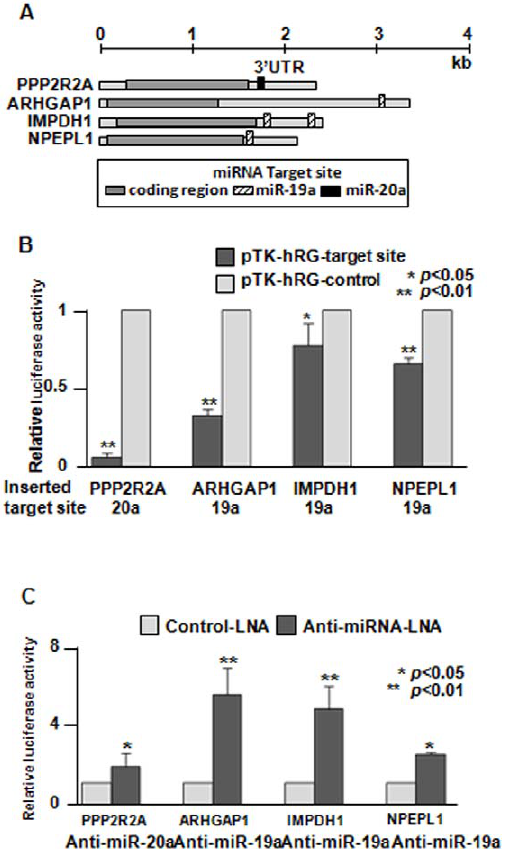
Figure 4. Verification of the results of the proteomic analysis data by luciferase assays. (A) Overview of target mRNAs. The miRNA target sites were identified in the 3 9 UTR of mRNAs using the Pictar, TargetScan or MiRanda software program. The 3 9 UTR fragments containing the miRNA target regions were synthesized as oligonucleo- tides and cloned into the 3 9 UTR of the Renilla luciferase of the pTK-hRG plasmid. (B) The luciferase activity of cells treated with constructs containing the miR-17-92 target sites was compared to that of cells treated with the control vectors, which had the same length of each target site, but in the reverse orientation. The data are shown as the means + SD. *, p , 0.05; **, p , 0.01 using a one-way ANOVA followed by Scheffe’s F-test (pTK-hRG-target site vs. pTK-hRG-control). (C) An anti- miRNA-LNA or control-LNA was co-transfected with the pTK-hRG-target site plasmids. The luciferase activity of anti-miRNA-LNA-treated group was compared to that of the control-LNA treated group. The data are shown as the means + SD. *, p , 0.05; **, p , 0.01 using a one-way ANOVA followed by Scheffe’s F-test (anti-miRNA-LNA vs. control-LNA).